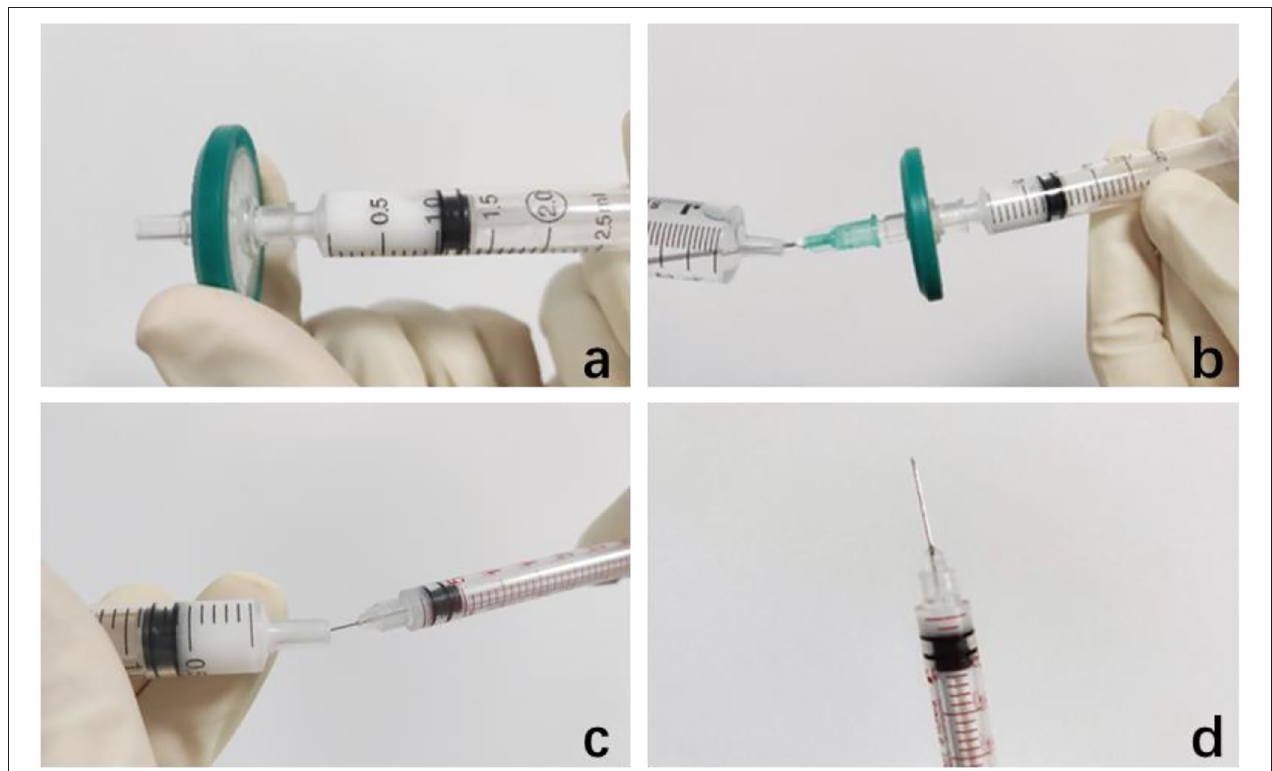
FIGURE 1 | Preparation of 2 mg/0.05ml triamcinolone acetonide (TA) injection. (a) Connect a filter with a diameter of 0.22 µ m at the front end of the needle, push off the excipients in the suspension, and keep the TA particles on the filter membrane. (b) Draw 2ml of eye-balanced salt solution to rinse it twice. (c,d) Transfer the 2 mg/0.05ml TA solution into 29G insulin syringe for